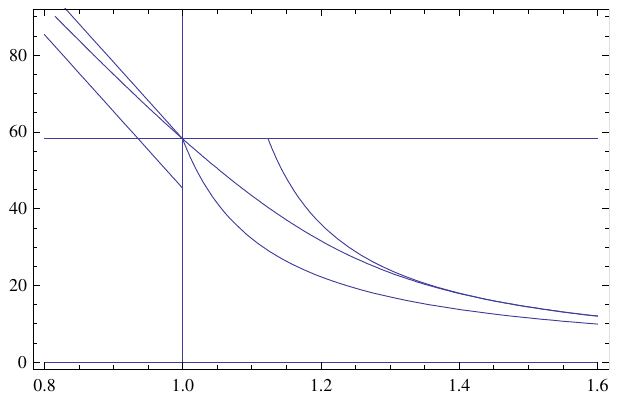
Figure 1. The function u t = 200 , and the bounds of Theorem 3. Horizontal line: u